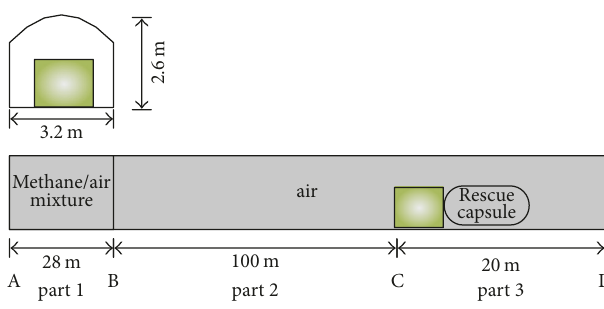
Figure 2: Length and cross section of the tunnel.